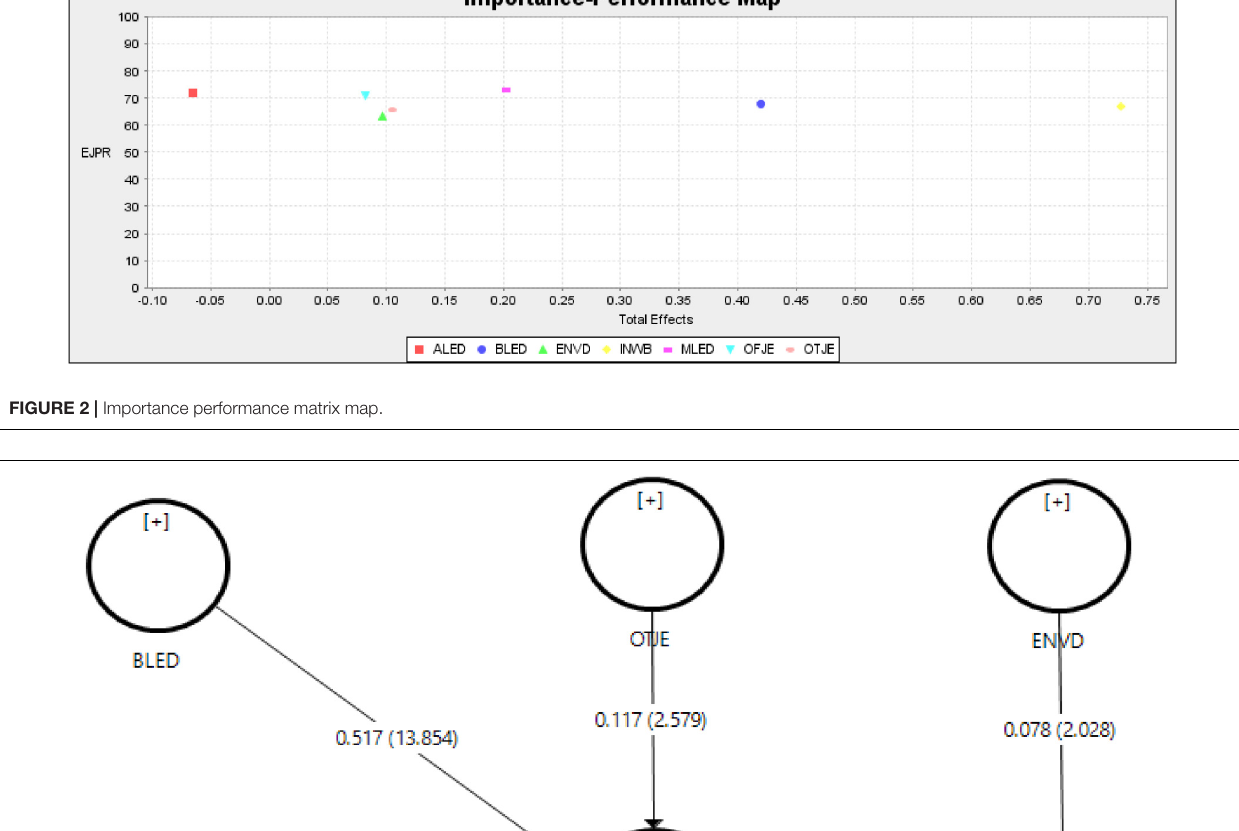
order to survive in this fierce and competitive business